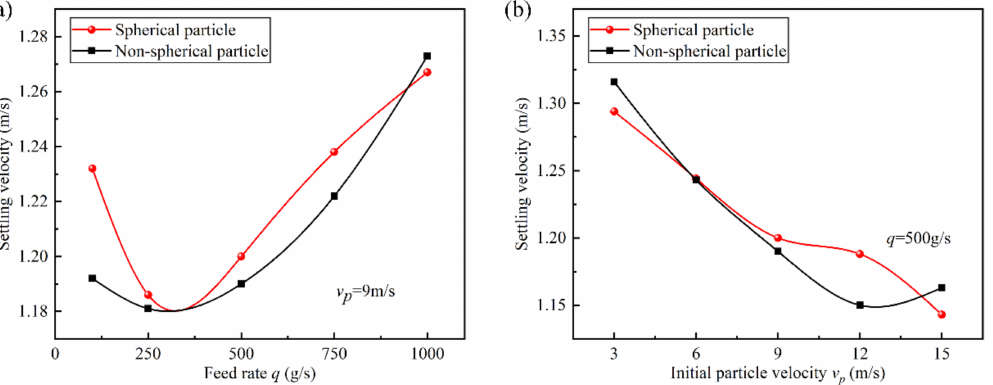
Figure 14. The effect of working parameters on settling velocity: ( a ) feed rate ( b ) initial particle